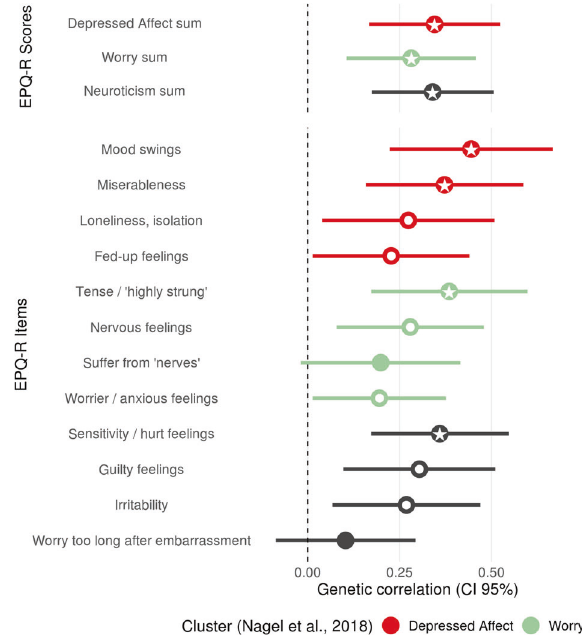
Fig. 2 Genetic correlations between Borderline Personality Dis- order with clusters and single items of the EPQ-R Neuroticism scale. Notes . Colors indicate membership to genetic clusters: red = “ Depressed Affect ” , green = “ Worry ” , dark grey = not assigned to a cluster. All data is based on the UK Biobank data sample [23, 25]. Within each cluster category, items are sorted by their genetic correlation with BPD; (cid:129) p < 0.05, * p < 0.0033 (0.05/15 tested correlations). 95% CI 95% con fi dence interval, EPQ-R Eysenck Personality Questionnaire status, corresponding to higher PGSs in the cases. Agreeableness showed a negative association with case-control status at one threshold ( PT = 0.05; NkR 2 = 0.42%, p = 0.0024), and no signi fi cant associations were observed for the PGS for Conscientiousness and Extraversion (see Fig. 3 and Supplementary Tables 1-5). A joint regression model including the signi fi cant PGS, explained 4.4% of the variance ( NkR 2 ) in BPD case – control status, and indicated an independent contribution of Neuroti- cism ( p = 2.2*10 − 16 ), Openness ( p = 0.00032) and Agreeableness ( p = 0.0060).